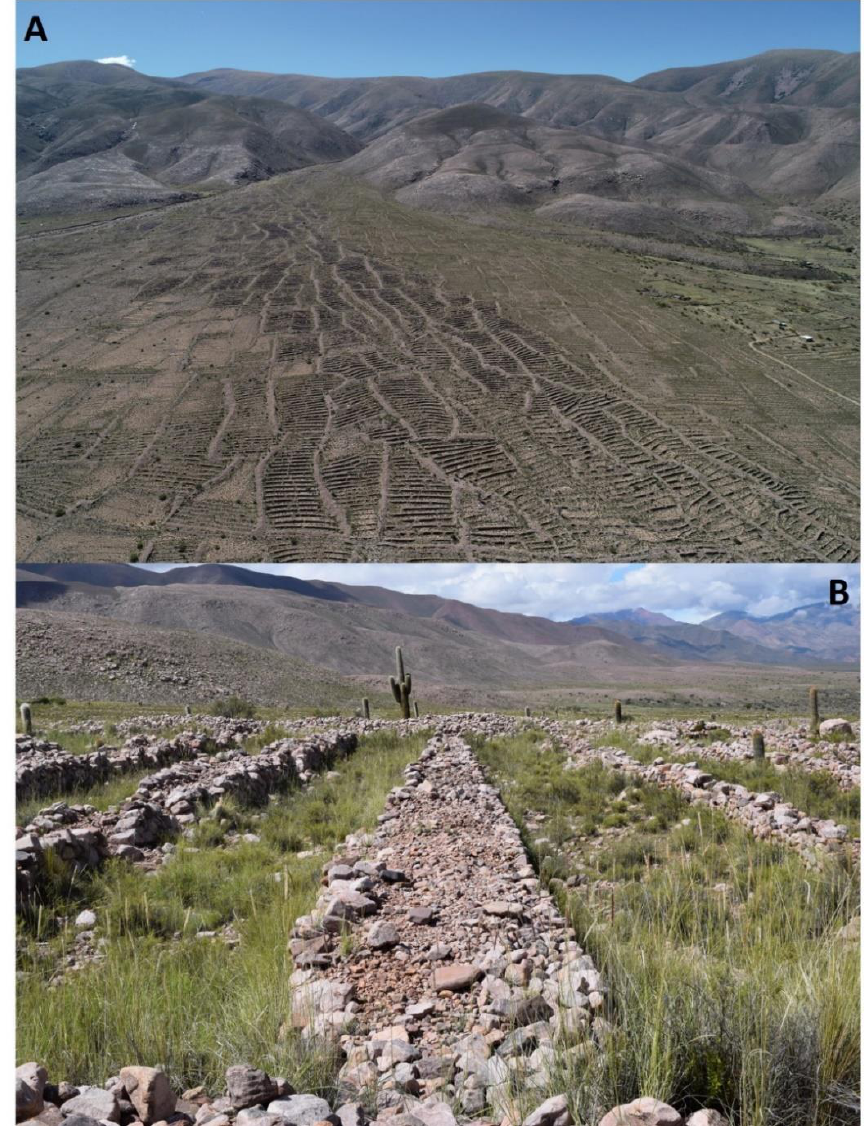
Figure 6. Inka cultivation enclosures in the locality of Coctaca. ( A ) Aerial view of the main sector with this type of crop surface, note the difference with the pre-existing agricultural substrate. ( B ) Ground view of Inka cultivation enclosures with a double-faced wall and filled with small stones (photo: Pablo Cruz, CONICET, 2019).